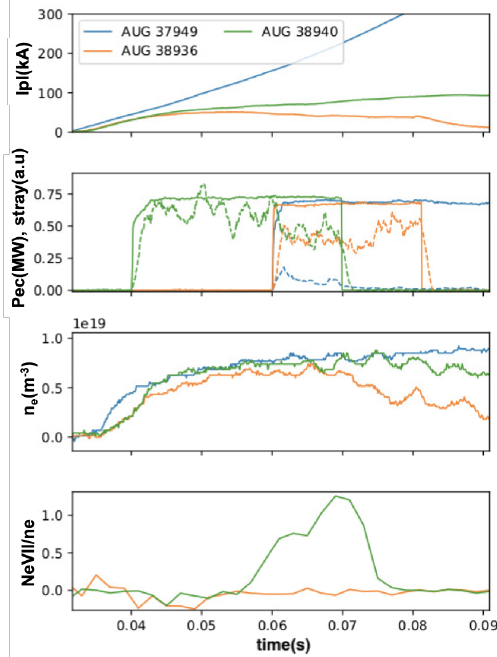
Figure 3. E ff ect EC onset at 40 or 60 ms, in conditions sum- marised in Table1. The stray radiation signals are plotted in arbi- trary unity. High stray level in #38936 (and consequently low EC absorption) between 60 and 90 ms does not indicate that longer pulse would have